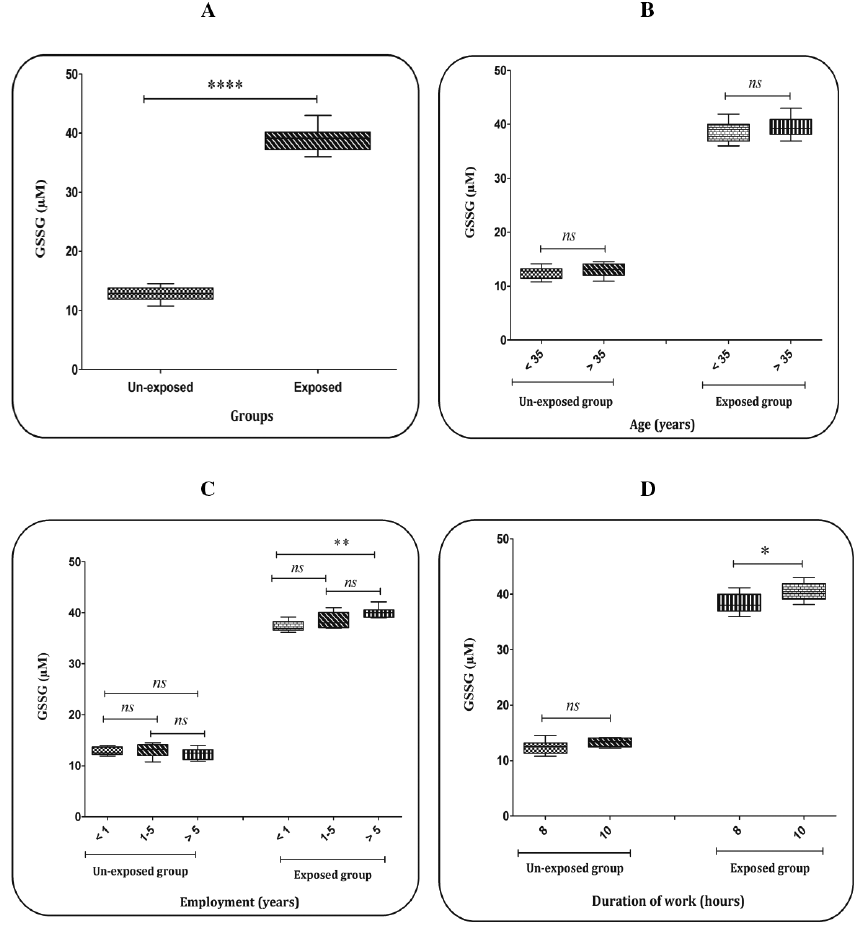
Figure 5: GSSG content assay. (a) Comparison between exposure and non-exposure groups. (b) Comparison between the exposed and unexposed groups based on age (year). (c) Comparison between the exposed and unexposed groups based on employment (year). (d) Comparison between the exposed and unexposed groups based on duration of work (hours). Data are presented as mean ± SD (n = 20). * P < 0.05, ** P < 0.01 and **** P <